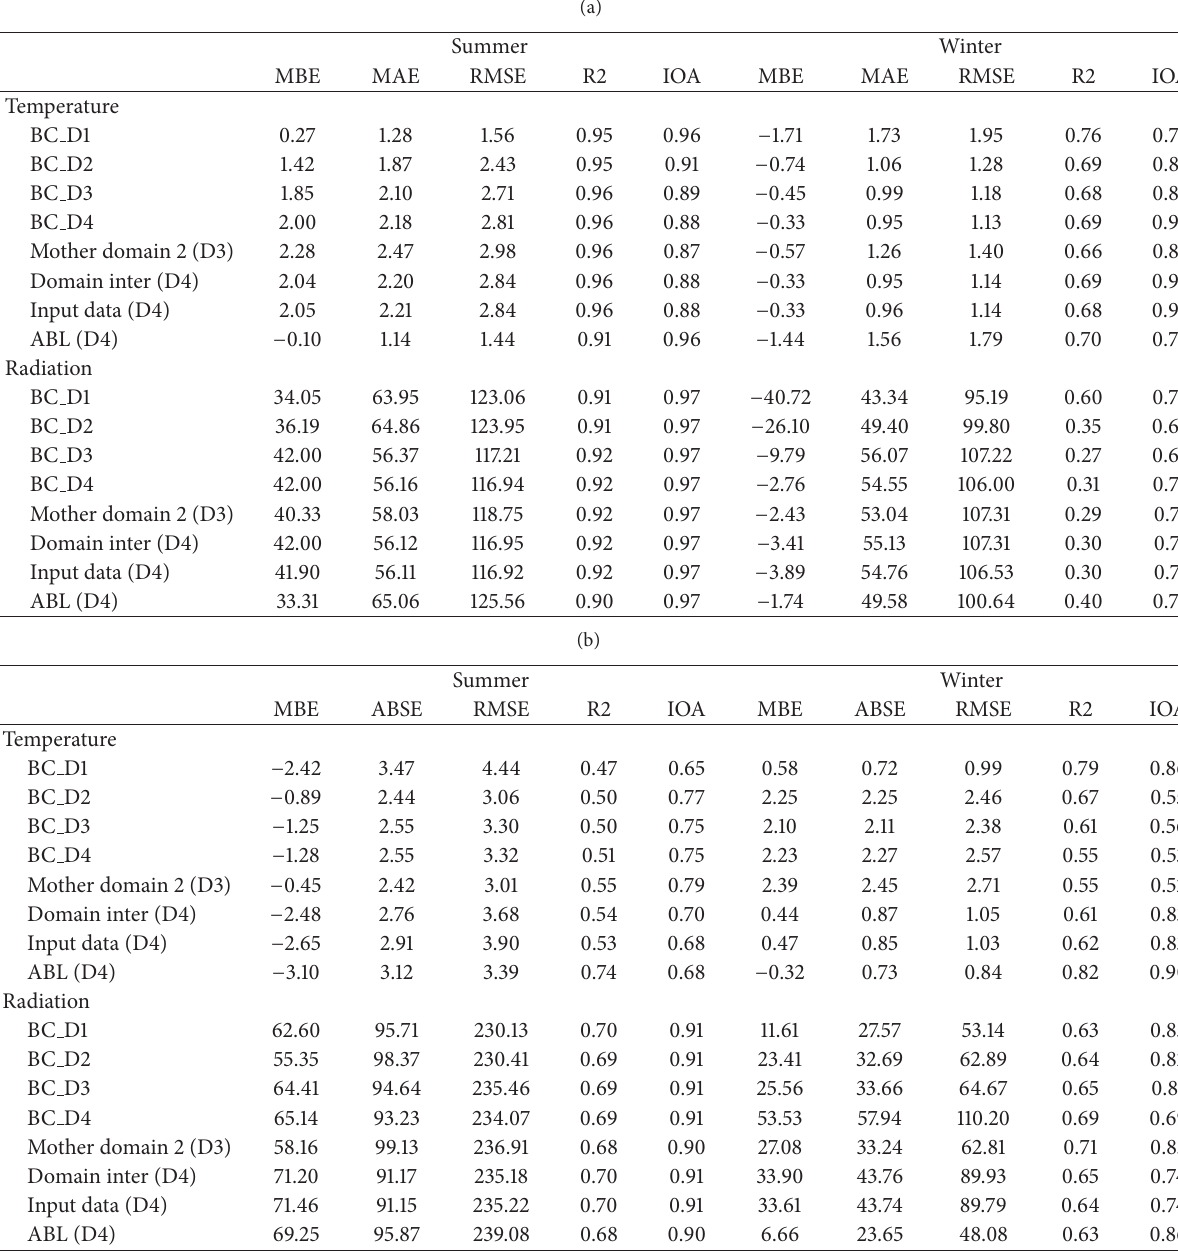
Table 2: (a) Results of the base-case and of the alternative scenarios for the location of Logro˜no. (b) Results of the base case and alternative scenarios for the location of